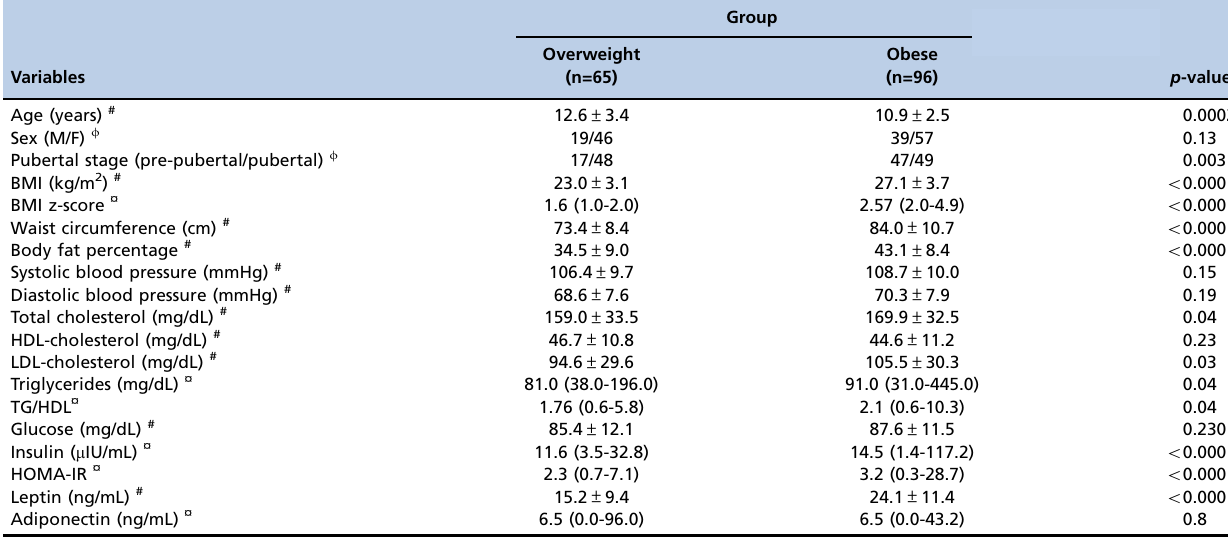
Table 1 - Clinical and laboratory characterization of overweight and obese children and adolescents recruited from the public schools of the Municipality of Uberaba, Minas Gerais State, Brazil, from February 2013 to July 2014.